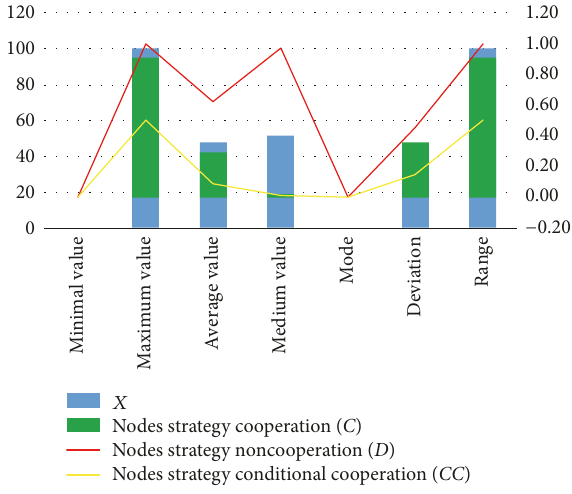
Figure 8: The state of population when 𝑋 = (0, 100, 47.97, 51.73, 0,